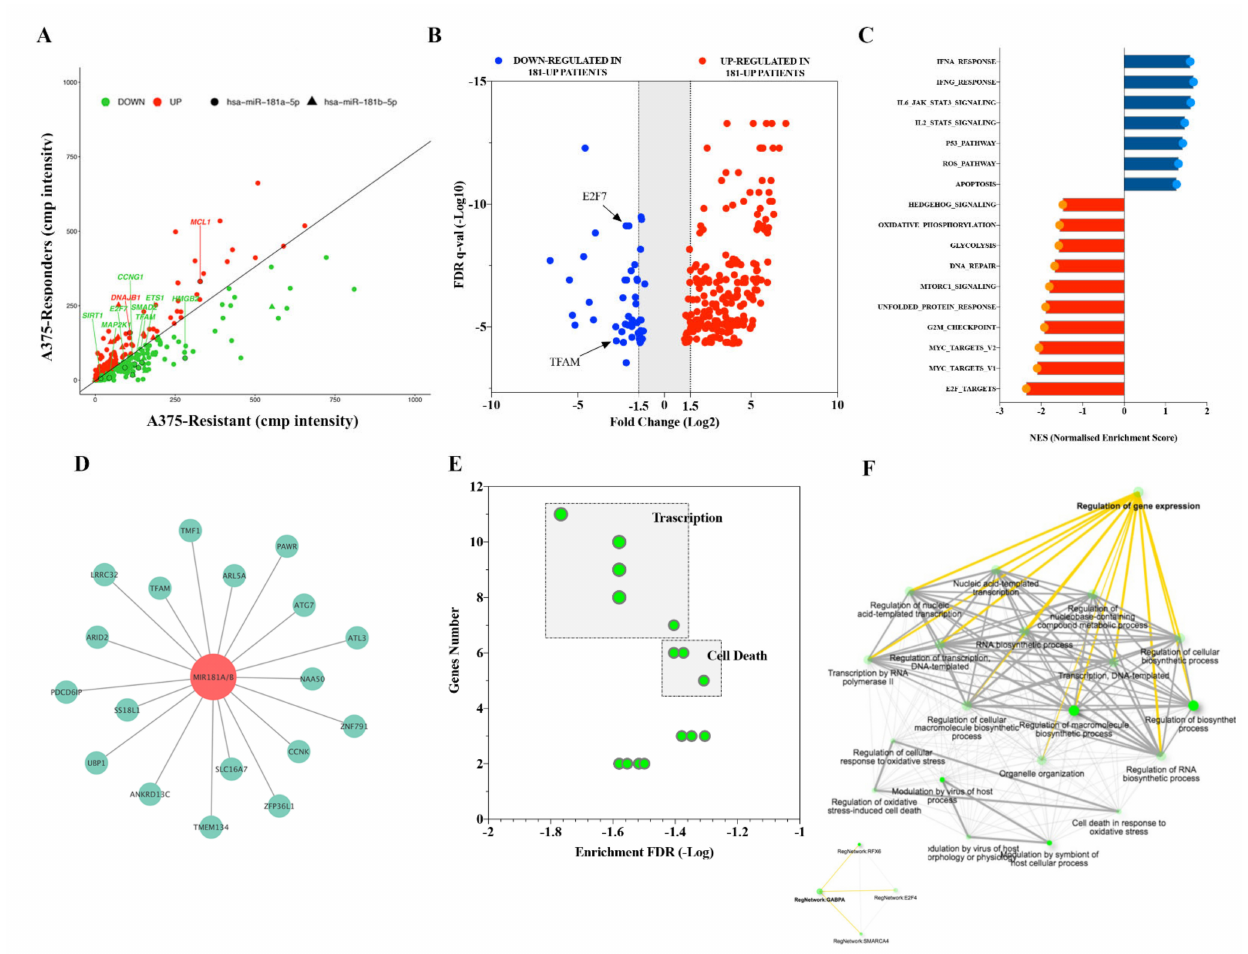
Figure 5. ( A ) Scatter plot of the RNA-Seq expression data showing differentially expressed miR-181a and -181b-target genes (DEG) between A375 (responders) and A375-BIR (resistant) cell lines. Dots represent DEGs that are: significantly overexpressed (red) and down-regulated (green). The most critical upregulated and downregulated DEGs targets are indicated. ( B ) Volcano plot showing the DEGs up (red dots) and down-regulated (blue dots) in patients expressing high levels of miR-181a and -181b (responders group). FDR: False discovery rate. ( C ) Plot of functional gene set enrichment analysis (GSEA) indicating hallmark gene sets significantly modulated in melanoma patients expressing high levels of miR-181a and -181b (responders group). ( D ) Network of miRNA-181a- and -181b-negatively regulated predicted target genes in melanoma patients (responders group) visualized by Cytoscape. Green dots represent predicted target genes and the red dot represents hub miRNA. ( E,F ) GO term enrichment analysis of miRNA-181a- and -181b-negatively regulated predicted target genes in melanoma patients (responders group). ( E ) Scatter plot of enriched GO pathways according to numbers of genes and FDR. ( F ) GO network analysis plot shows the relationship between enriched pathways. Darker green nodes are more significantly enriched gene sets. Bigger nodes represent larger gene sets. Most critical networks are highlighted in